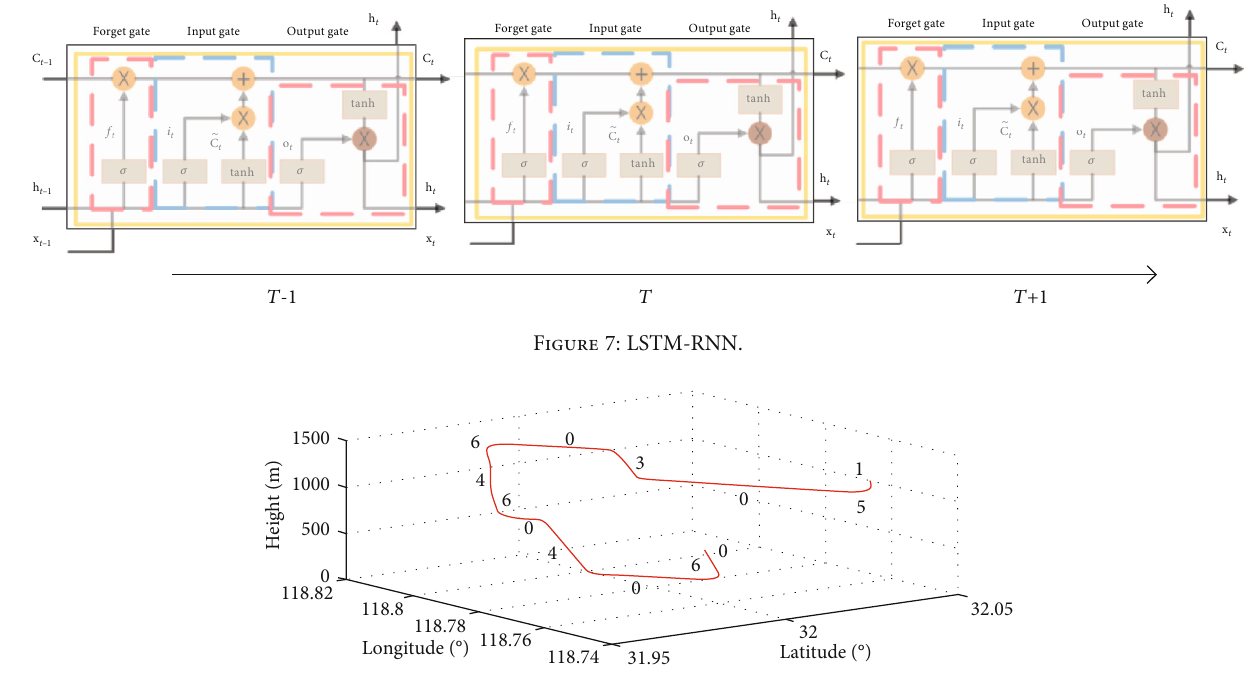
Figure 8: 3D plot of the employed dynamic trajectory. Table 1: Motion details of the trajectory. Table 2: Acquisition